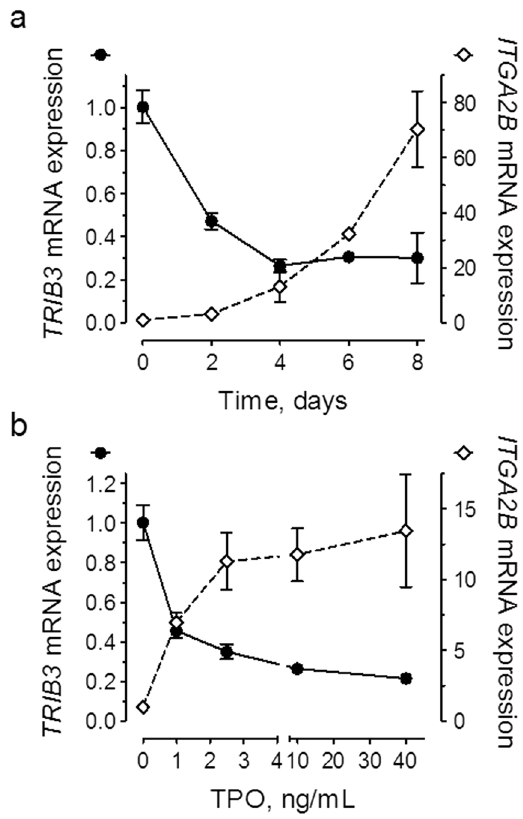
Figure 1. TPO induces a time and dose-dependent decrease of TRIB3 mRNA levels. ( a ) Primary haematopoietic cells were grown under megakaryocyte differentiation conditions with 40 ng/mL TPO for the indicated lengths of time, or ( b ) for four days with the indicated doses of TPO. Gene expression levels are expressed relative to the respective transcript levels at the initiation of the culture period. Results are representative of three independent experiments. Error bars denote SD of technical replicates (n = 3–6). Error bars smaller than the size of the symbol are not